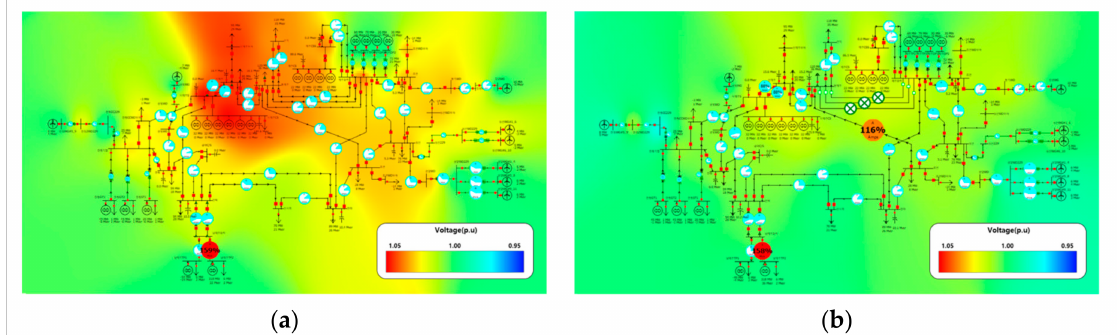
Figure 7. Review of case study with probabilistic summer scenario: ( a ) Results of security analysis pre-N-1 contingency; ( b ) results of security analysis post-N-1